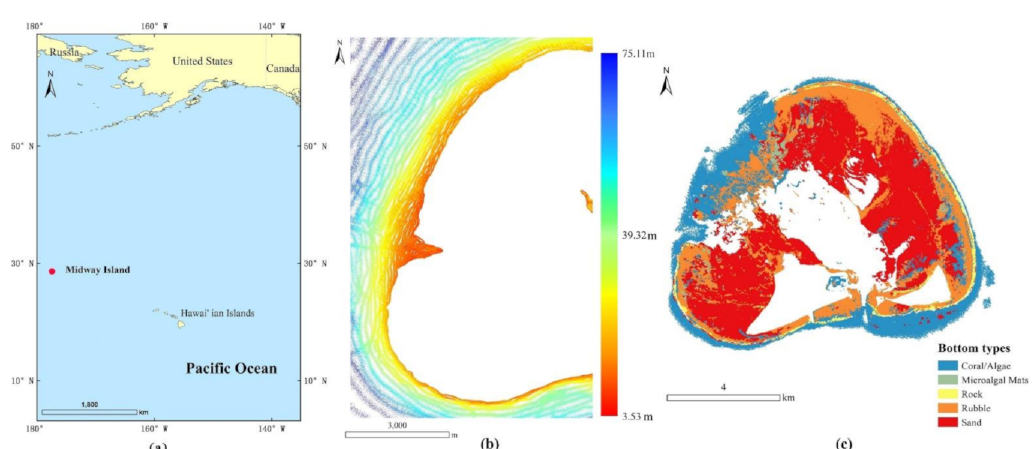
Figure 5. ( a ) Location of Midway Island. ( b ) Distribution map of measured water depth data around Midway Island. ( c ) Benthic map of the Allen Coral